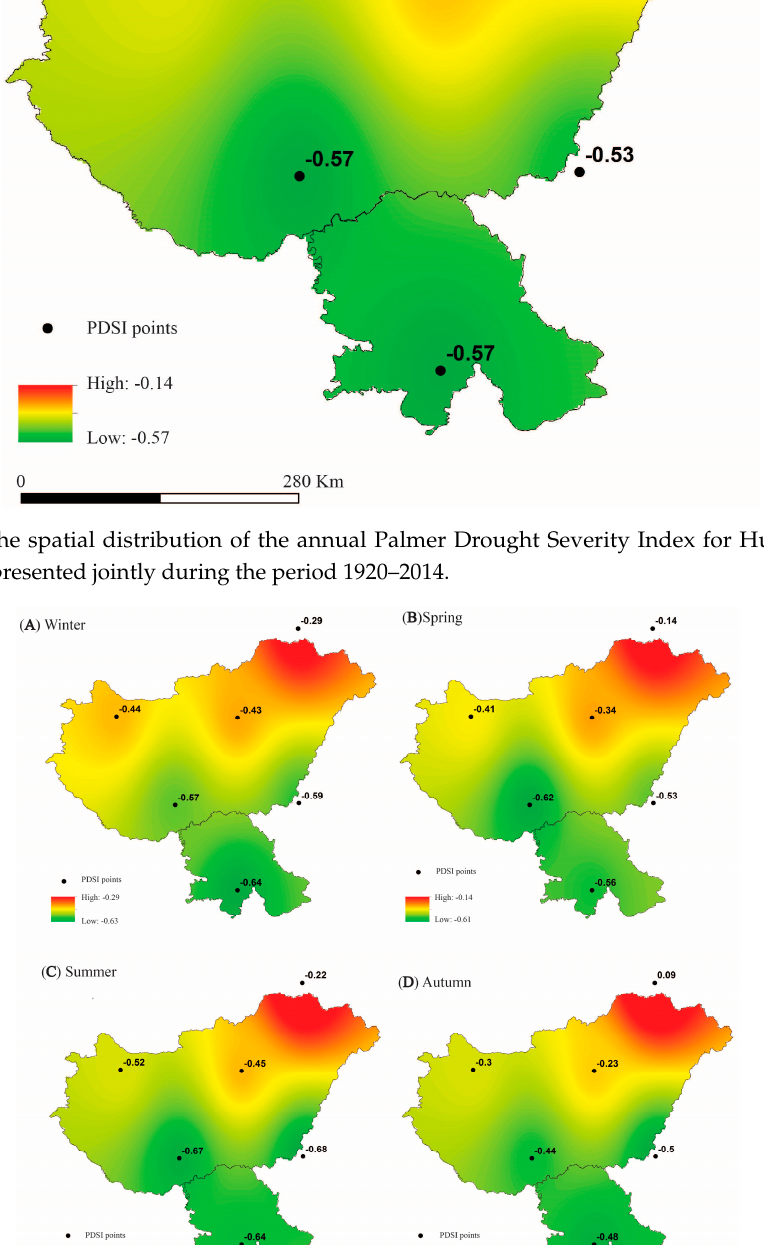
Figure 8. The monthly distribution of the mean monthly Palmer Drought Severity Index for Hungary and Vojvodina presented jointly during the period 1920 – 2014.